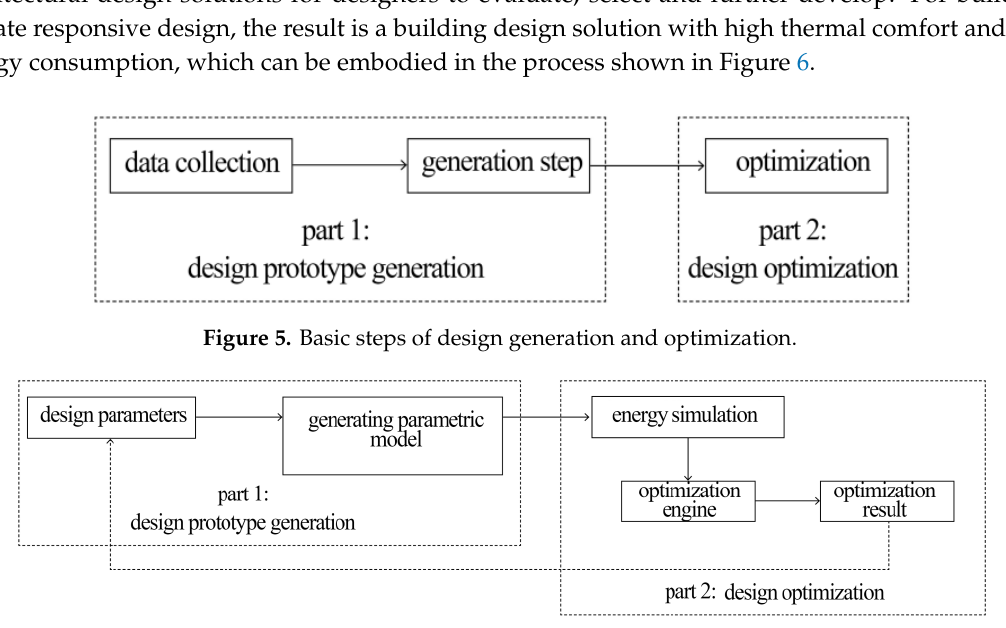
Figure 6. Simulation based modeling and optimization process.